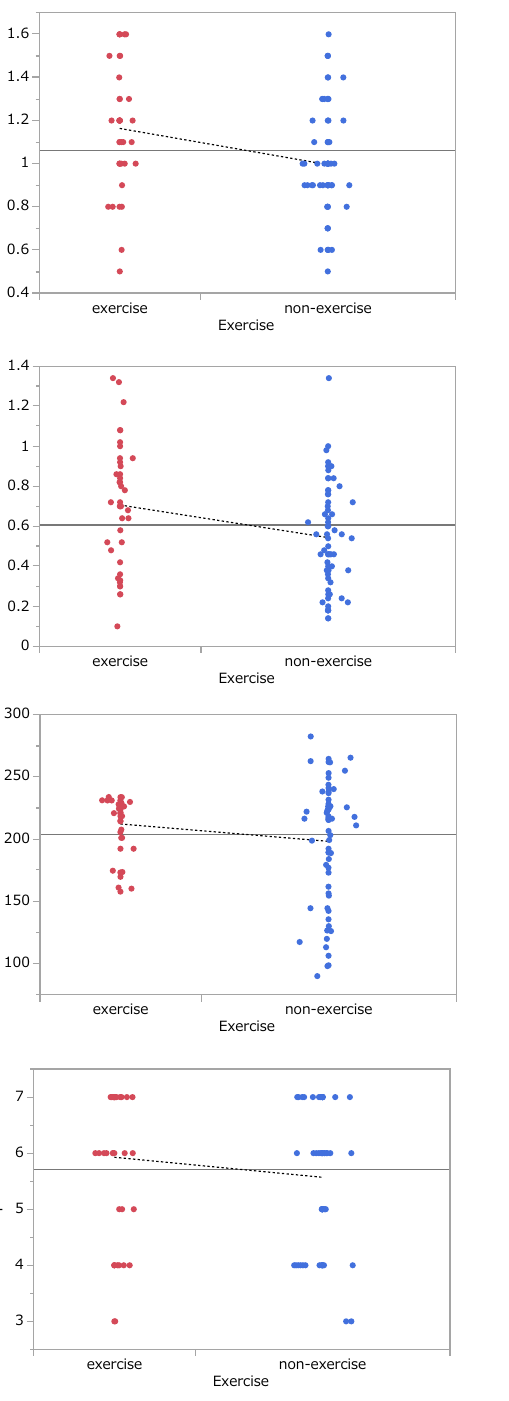
Figure 1. Scatterplots for all 8 tests. Notes: Solid lines indicate the mean of both groups. The mean values for each group are plotted and connected by broken lines. Abbreviations: SVA: static visual acuity, KVA: kinetic visual acuity, DVA: dynamic visual acuity, CS: contrast sensitivity, OMS: ocular motor skill, DP: depth perception, VRT: visual reaction time, E/H: eye hand